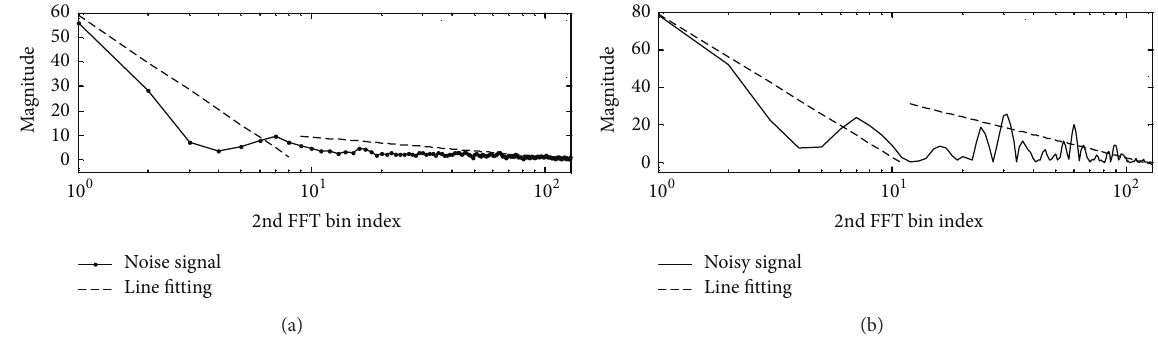
Figure 5: Result of fitting the line to spectrum magnitude obtained from the noise-only signal and the noisy signal of Figure 4(b): (a) line fitting to the magnitude of noise signal and (b) line fitting to the magnitude of noisy